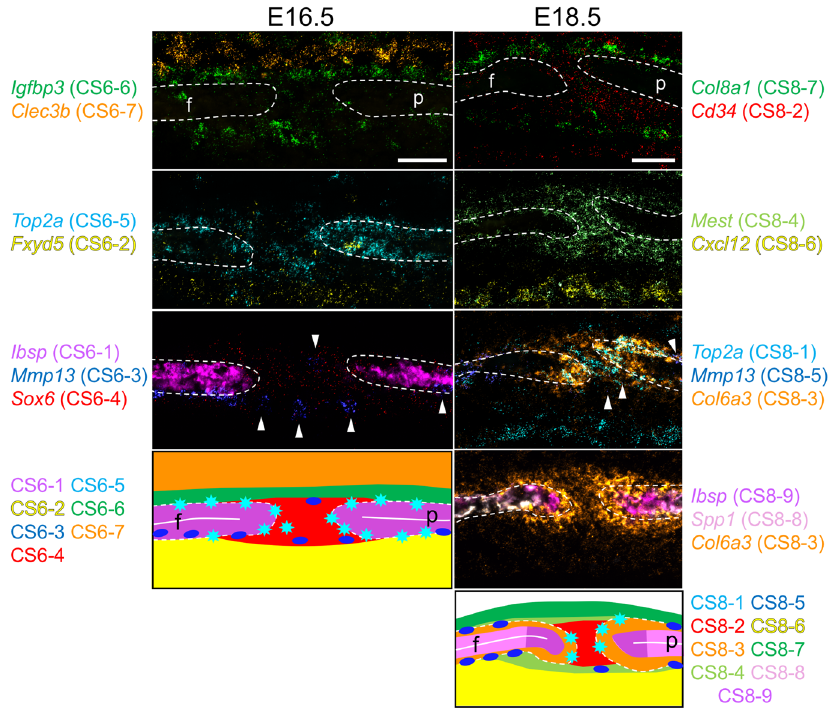
Fig. 8 Localization of Hhip − / − coronal suture populations by smFISH. Each pseudo-colored panel shows an individual section hybridized with probes for the indicated genes at each age. Expression of the E18.5 CS8-2 marker, Cd34 , can be compared to WT in Supplementary Fig. 3a. Schematics summarize the spatial distribution of populations, color-coded as in smFISH. White arrowheads indicate novel Mmp13 expression. Dashed outlines indicate frontal (f) and parietal (p) bones; white horizontal lines indicate osteoid. Sections are in the transverse plane. smFISH was performed on three independent samples with similar results. Scale bars, 50 μ m.